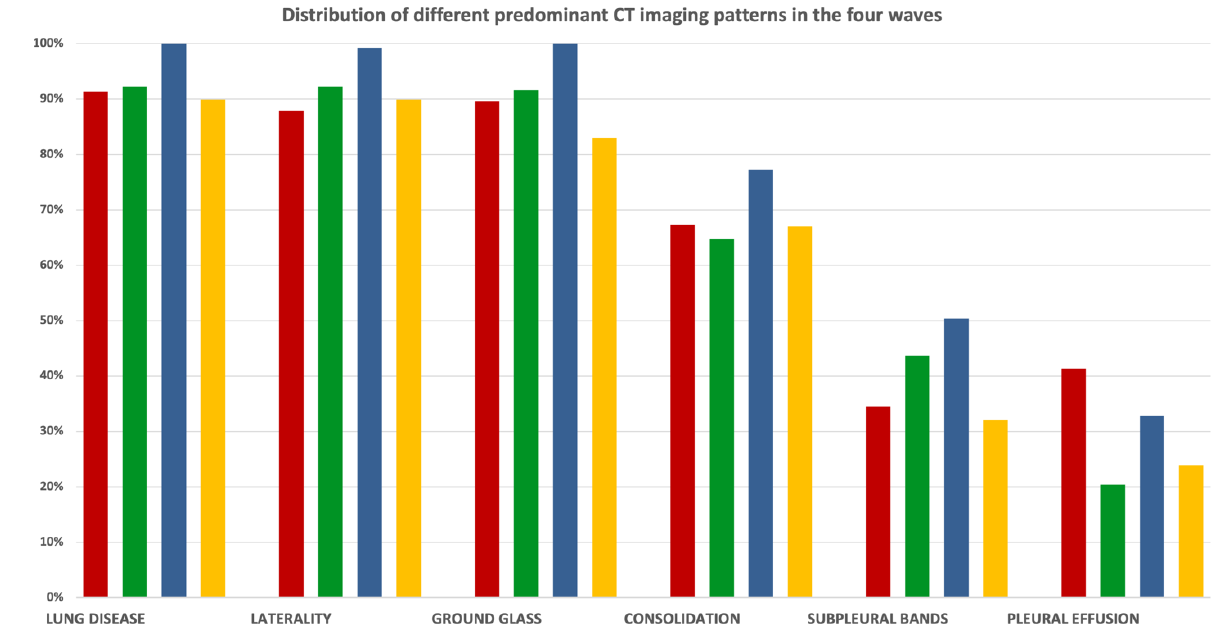
Figure 3. Percentage distribution of predominant CT patterns in the four waves.